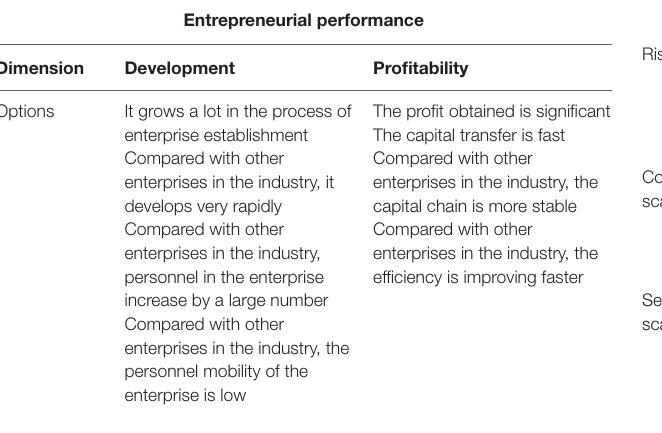
TABLE 3 | Entrepreneurial performance